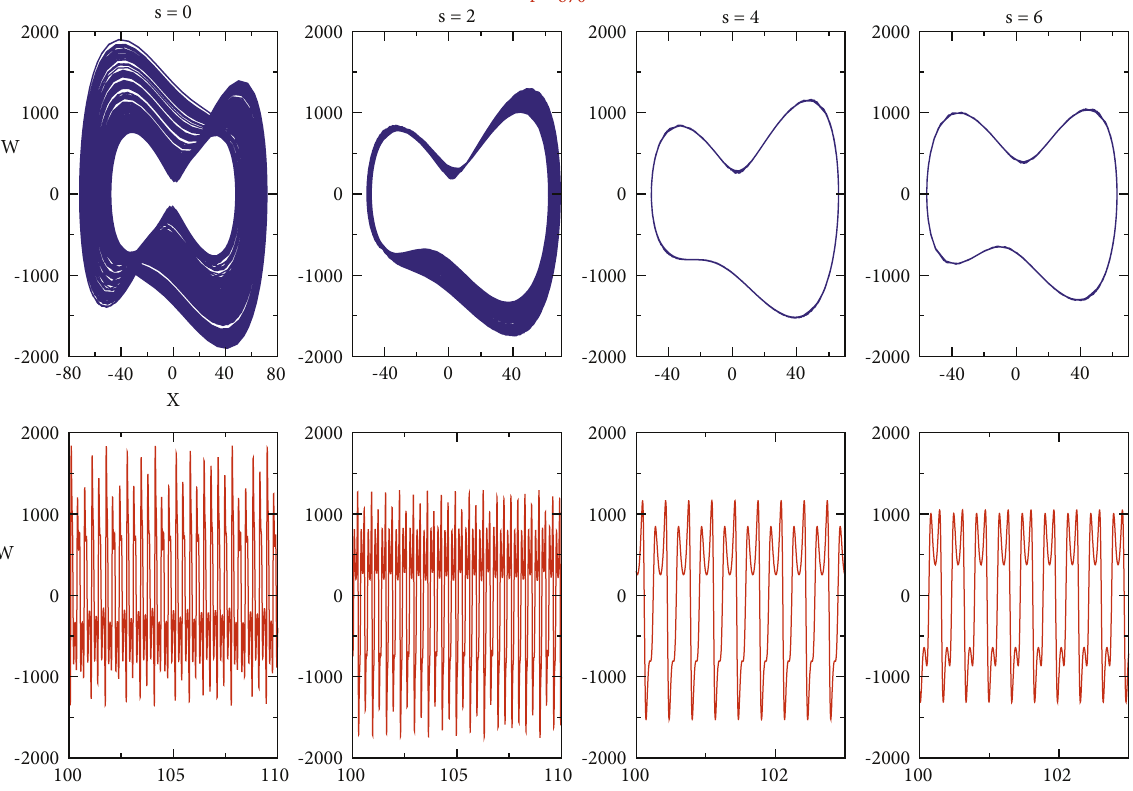
Figure 6: Phase portraits and time stories of the system for a fixed reduced Rayleigh number r � 670 and different values of s with the parameter values of Figure 5.